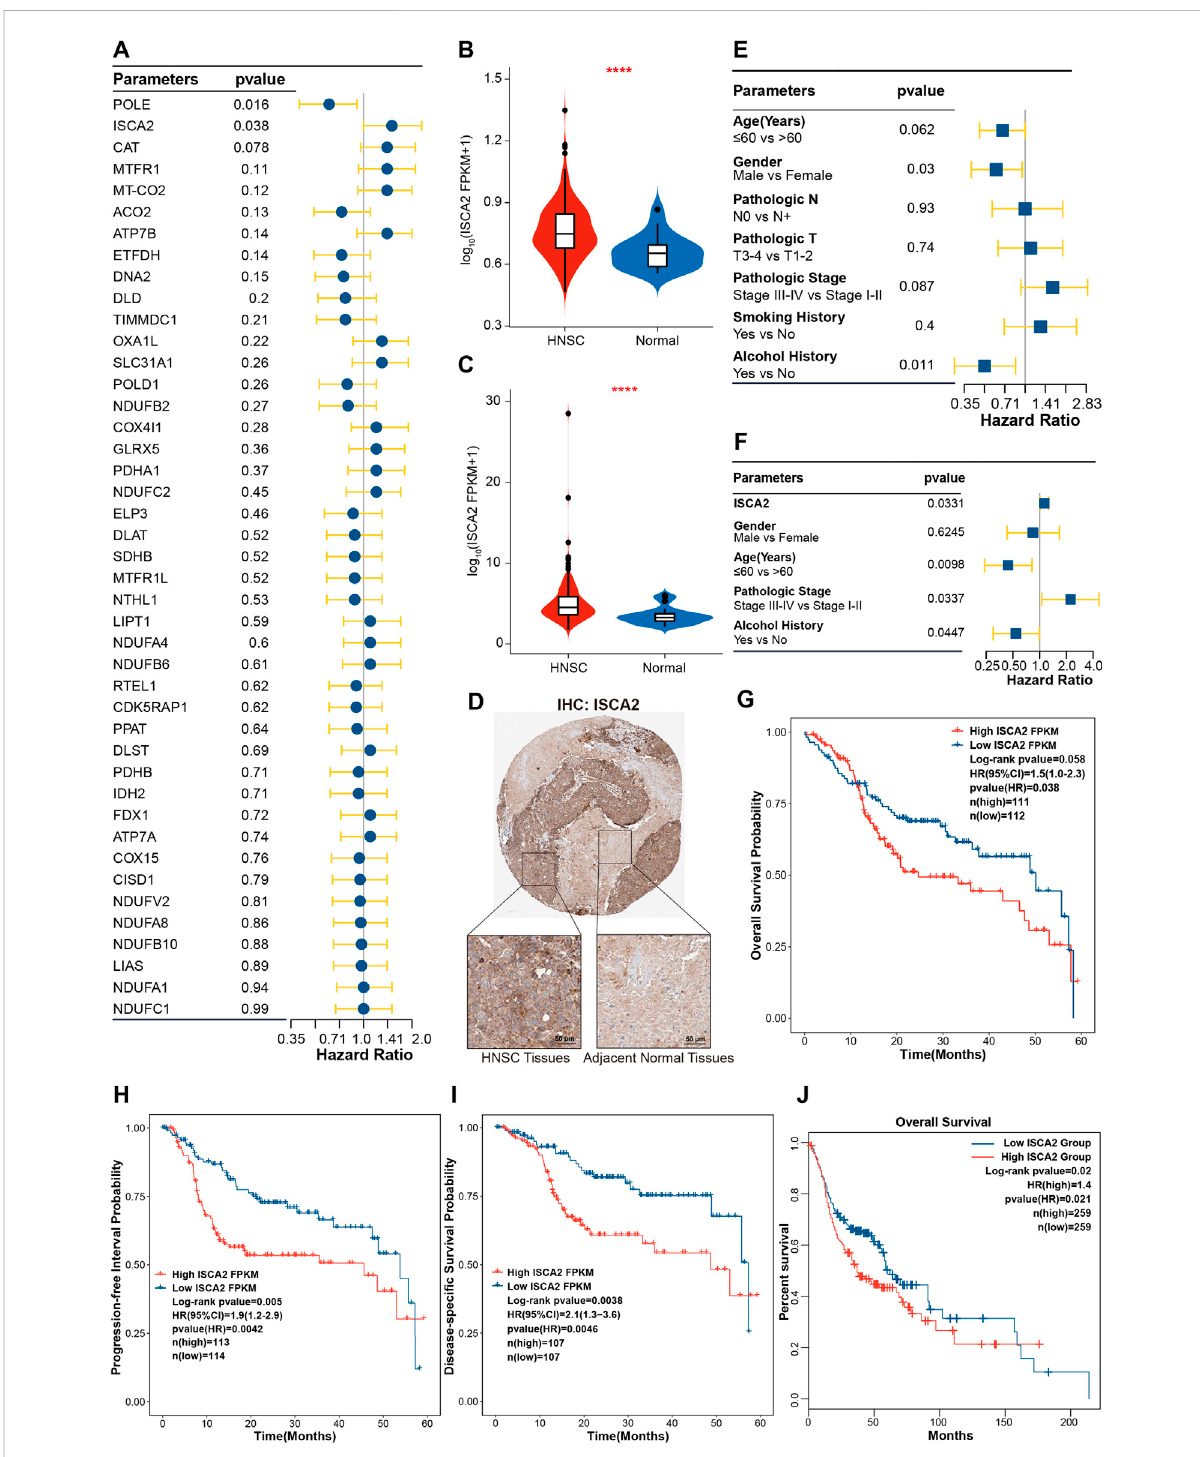
FIGURE 4 ISCA2 was upregulated and signi fi cantly correlated with HNSC progression (A) Univariate Cox regression analysis of CRGs (B , C) Boxplot showing ISCA2 expressioninTCGA- fi rst (B) and TCGA-second (C) cohorts (D) Validation of ISCA2 expression byIHC in HNSC and normal tissues (E) Univariate Cox regression analysis of clinical features (F) Multivariate Cox regression analysis of risk factors consisting of ISCA2, gender, age pathologicstage,andalcoholhistory (G – I) Kaplan-MeiercurveshowingtheassociationofISCA2expressionwiththe5-yearOS (G) ,PFI (H) ,and DSS (I,J) Association of ISCA2 with the OS in all TCGA HNSC samples as veri fi ed GEPIA2 webserver. ****p-value <